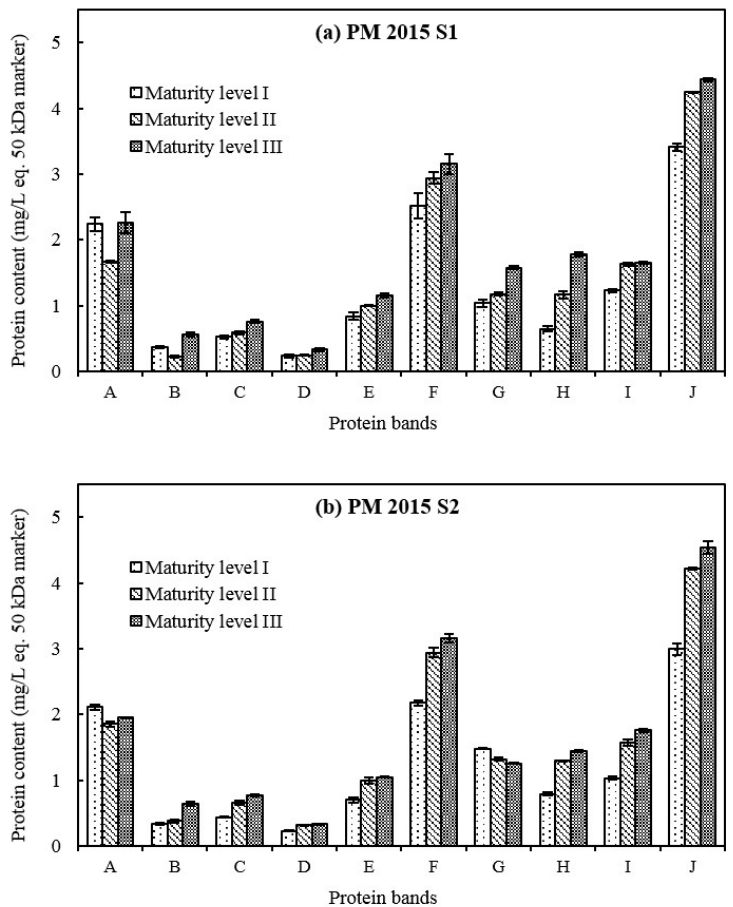
Figure 2. Concentrations of 10 major wine protein bands from Pinot meunier (PM) S1 ( a ) and S2 ( b ) base wines in vintage 2015. Error bars represent the standard deviation of three replicates .